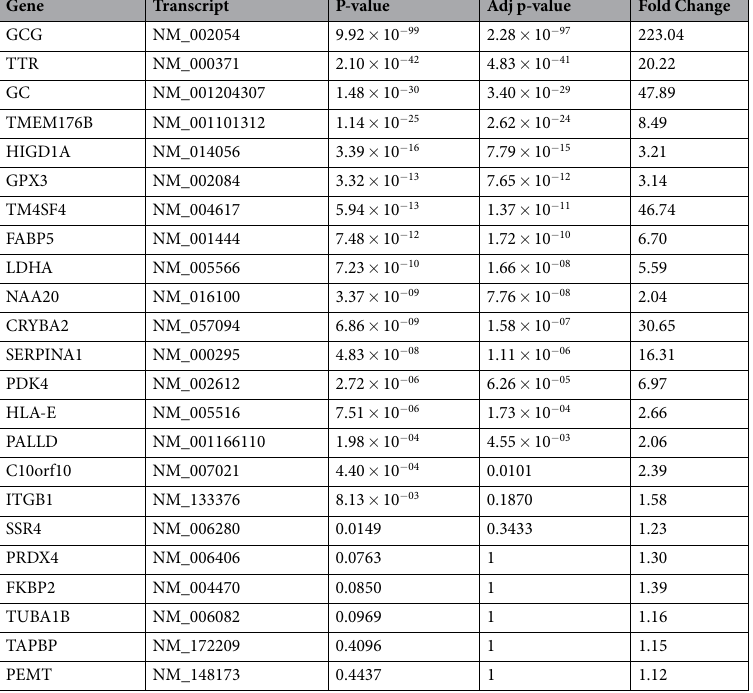
Table 2. In silico replication of unique α -cells upregulated genes reported in recent human non-diabetic islet single-cell studies 8–11 . Adjusted P-value corrected for 23 transcripts